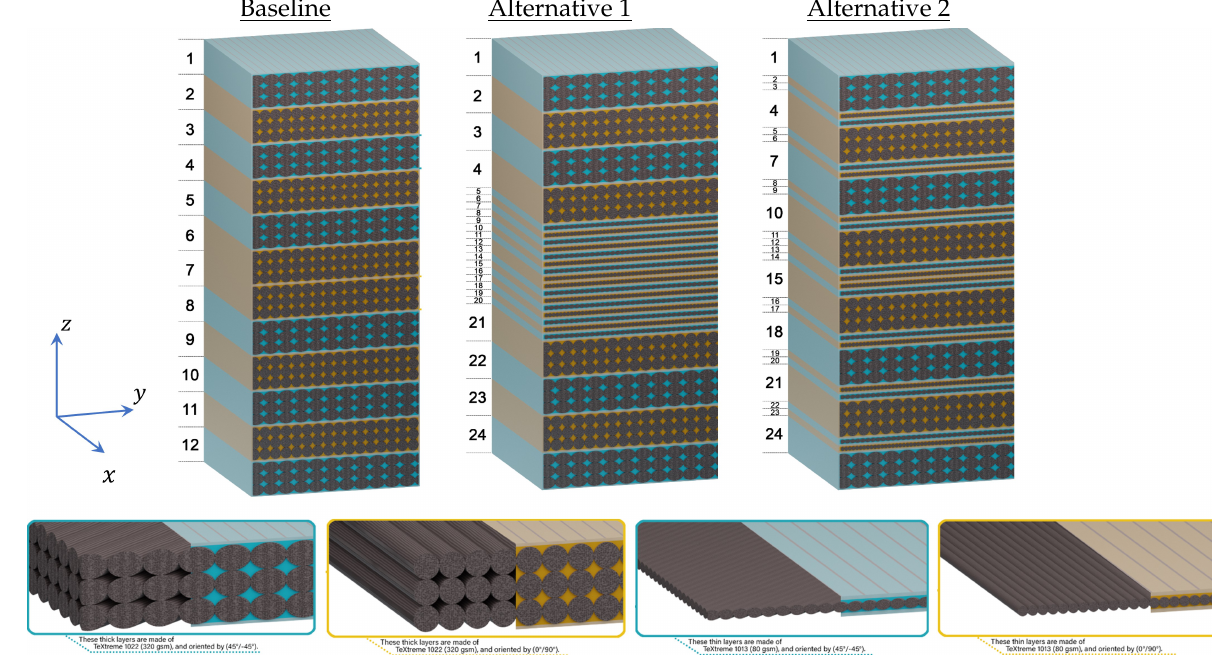
Figure 1. Schematic of the cross-section properties of the three stacking